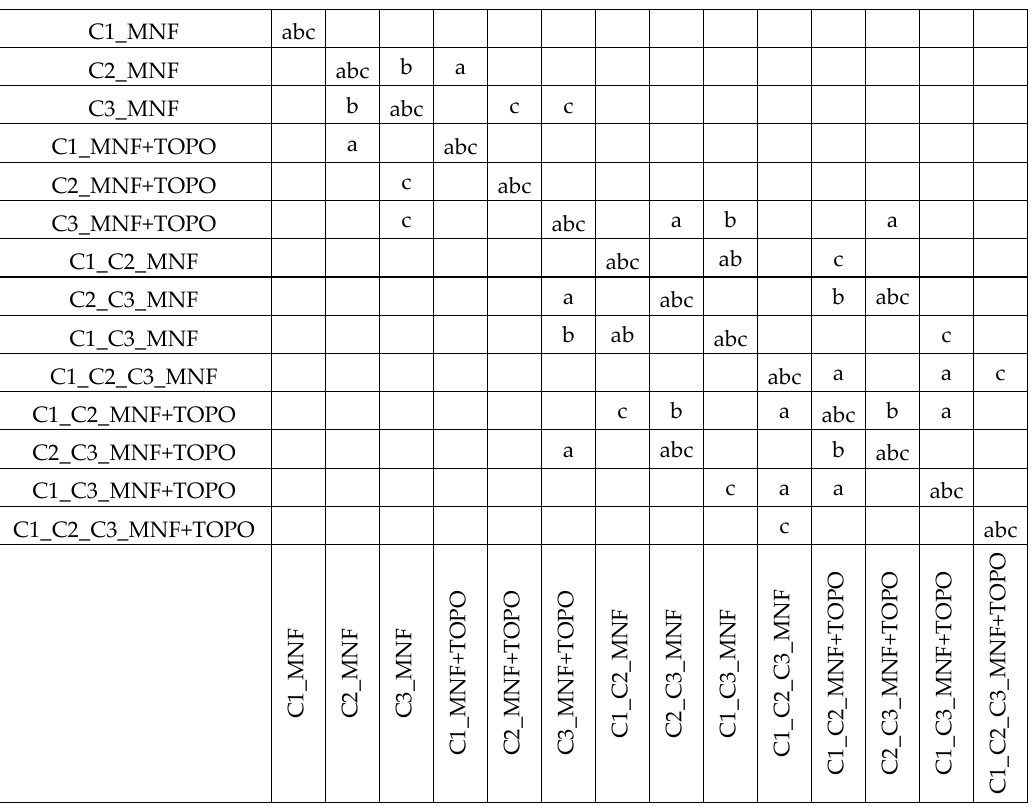
Table 5. Datasets for which F1 accuracy di ff erences were not significant statistically using U Table 5 . Datasets for which F1 accuracy differences were not significant statistically using U Mann-